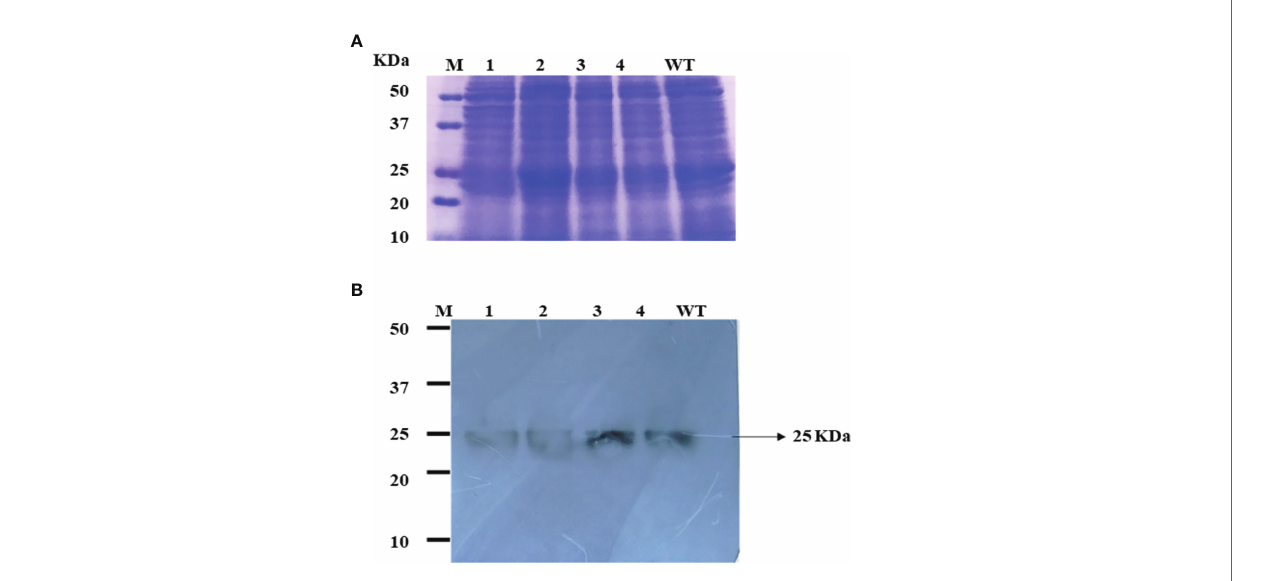
FIGURE 4 | (A) SDS-PAGE pattern of the total soluble protein obtained from the transformed and wild-type Chlorella vulgaris . Gel stained with Coomassie brilliant blue. M, molecular weight marker; line 1, SM-L colony; lane 2, SM-NL colony; lane 3, S-L colony 1; lane 4, S-L colony 2; WT, wild type (negative control). (B) Western blot analysis of bFGF protein produced in the chloroplast of C. vulgaris . Crude proteins were extracted from chloroplast-transformed C. vulgaris cultures, and the expression of bFGF protein was analyzed on SDS-PAGE, followed by Western blot, and probed with a rabbit anti-his antibody conjugated with HRP. M,